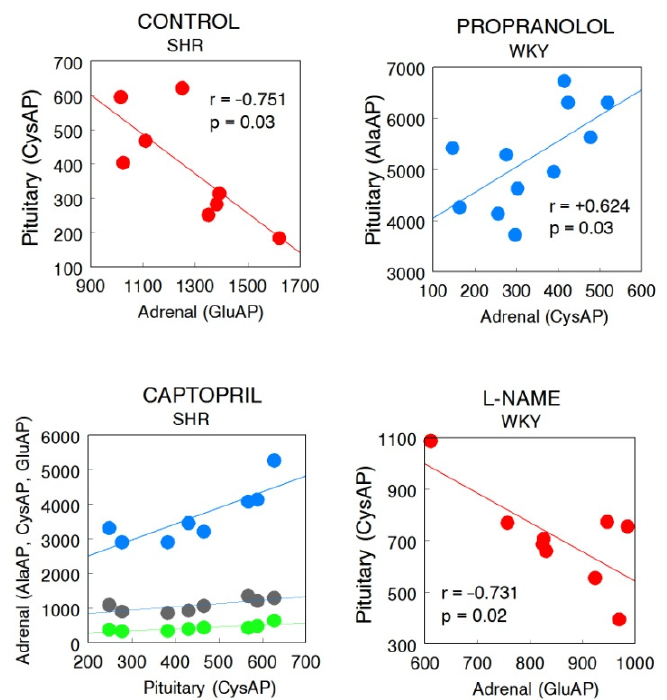
Figure 5. Inter-gland significant correlations obtained between the aminopeptidase activities ana- lyzed in pituitary and in adrenals under the different treatments in WKY or SHR. In captopril-treated SHR: AD AlaAP vs. PT CysAP (blue) (r = +0.817, p = 0.01); AD CysAP vs. PT CysAP (charcoal) (r = +0.812, p = 0.01); AD GluAP vs. PT CysAP (green) (r = +0.737, p = 0.03).